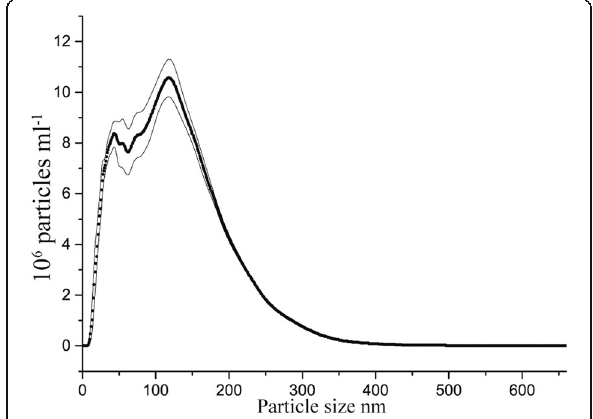
Fig. 11 Hydrodynamic particle size distribution in water, as measured by NTA, of γ -Fe 2 O 3 synthesized through yttrium directed sol-gel synthesis. Values are averaged from four repeated measurements, and the area within the thin lines represent mean error